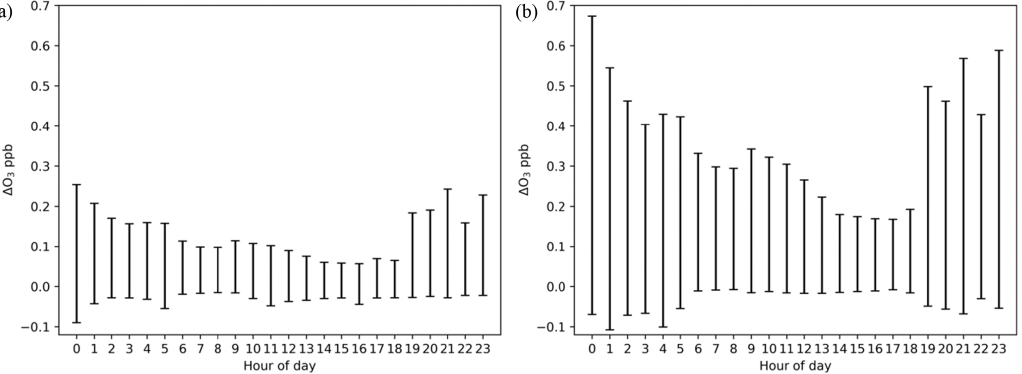
Figure 4. The predicted differences in hourly ozone concentrations (ppb) across the entire Colorado domain, over the 90d simulation for the (a) 5_DPW and (b) 3_EC scenarios.